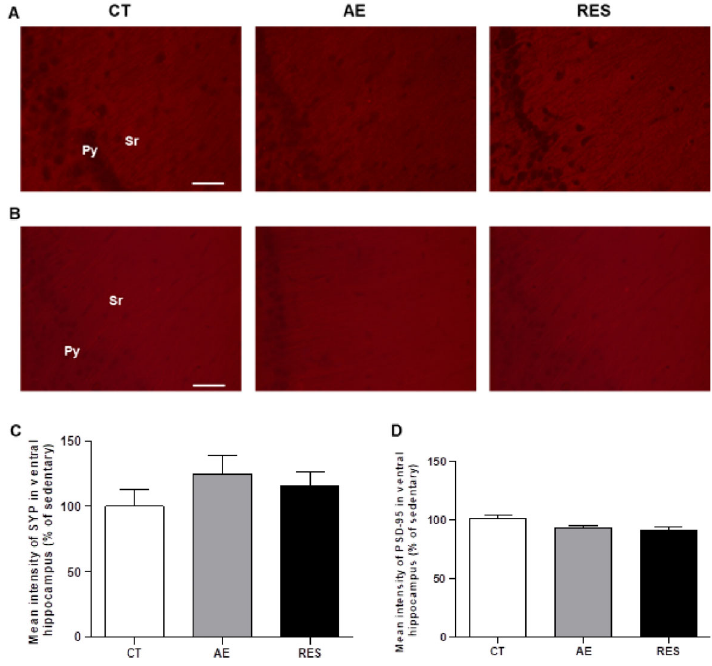
Figure 6. Analysis of neuroplasticity markers in the ventral hippocampus. Photomicrographs of stratum radiatum stained for SYP ( A ) and PSD-95 ( B ) in the ventral cornus ammonis 1 region (400 (cid:1) magni fi cation, scale bar=50 m m). Quanti fi cation of the immuno fl uorescence relative intensity (% of sedentary control) for SYP ( C ) and PSD-95 ( D ). One-way ANOVA followed by Tukey ’ s post hoc . Data are reported as means ± SE (n=4 – 6 per group). SYP: synaptophysin; PSD-95: postsynaptic density protein 95; Sr: stratum radiatum ; Py: pyramidal cells layer; CT: sedentary control; AE: aerobic exercise on the treadmill; RES: resistance exercise on the ladder